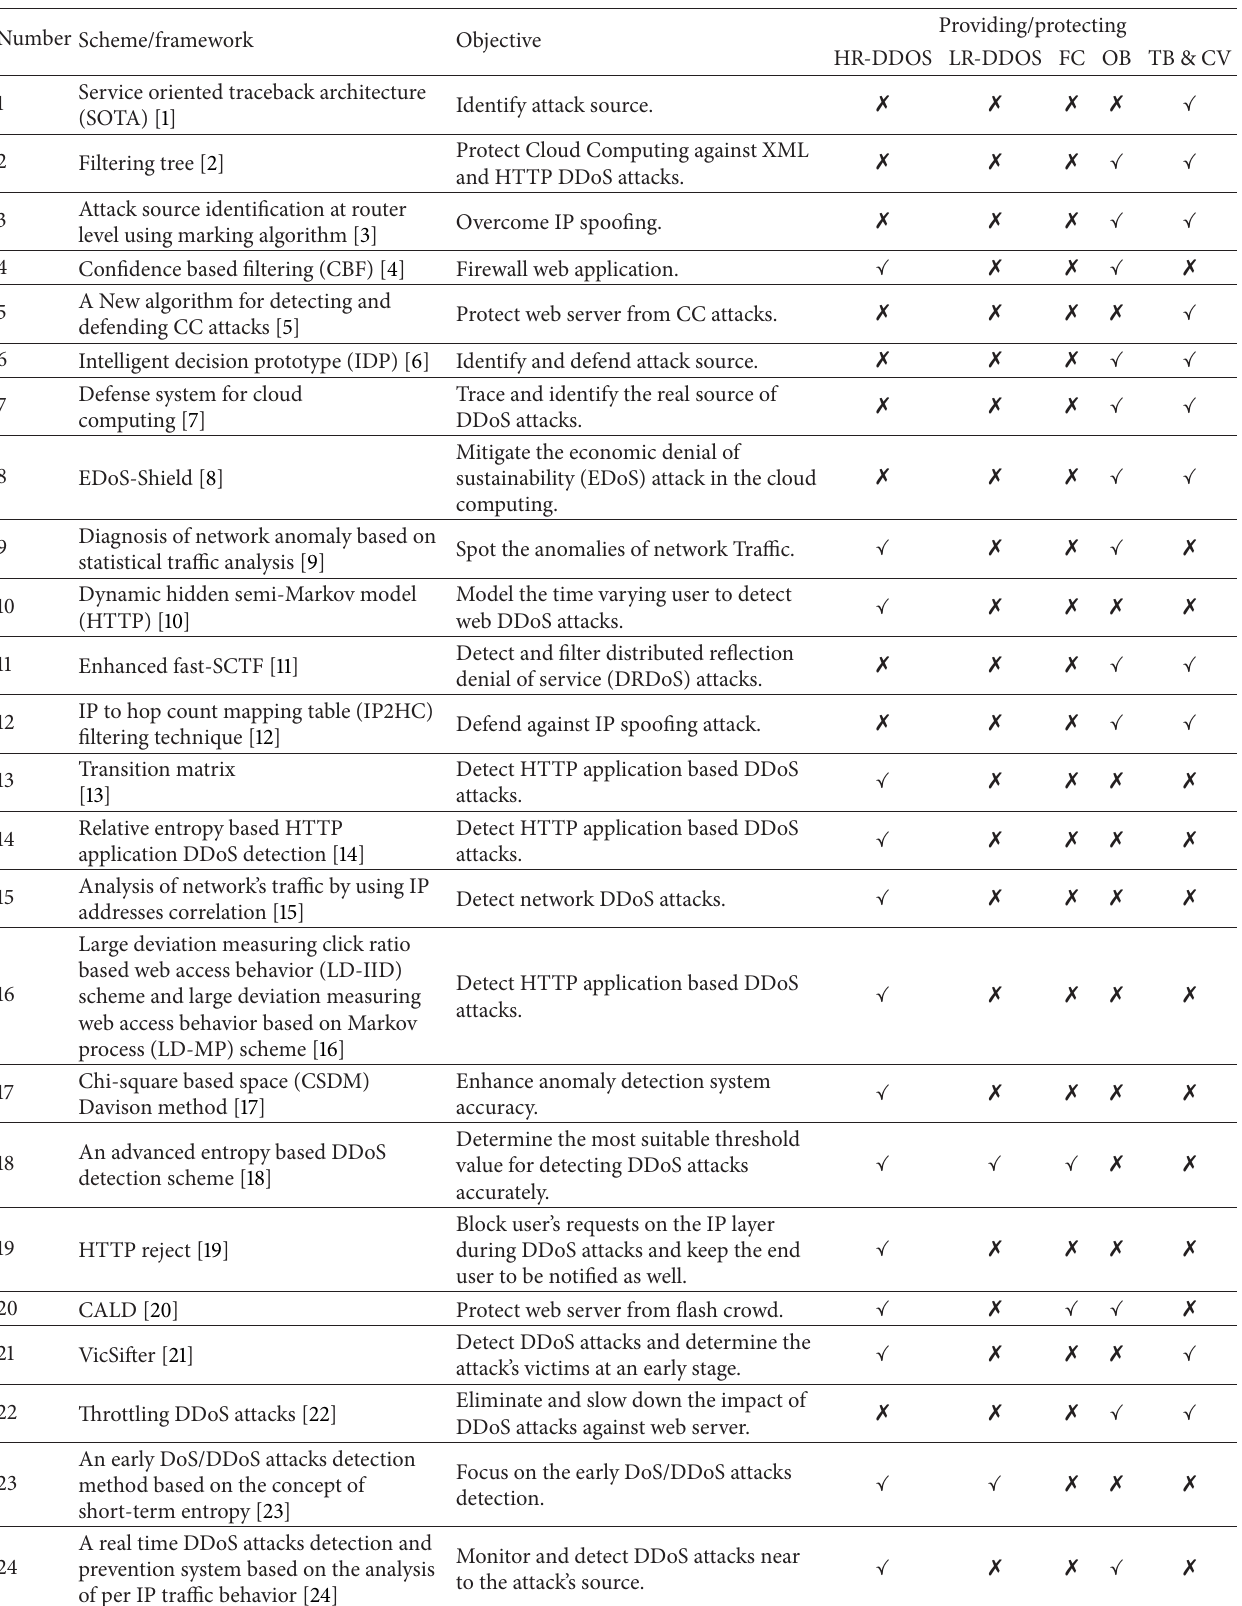
Table 1: Comprehensive survey on detective and preventive schemes and frameworks to all sorts of HTTP-based DoS And DDoS Attacks. Number